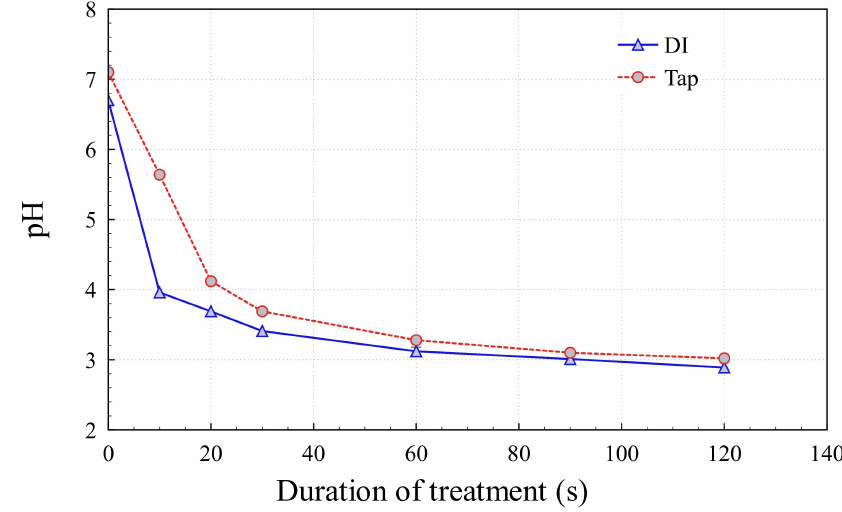
Figure 4. pH value of DI and tap water as a function of the duration of plasma